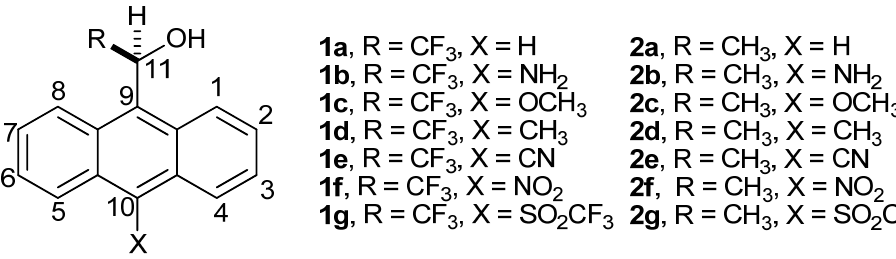
Figure 1. 1-(9-anthryl)ethanol and